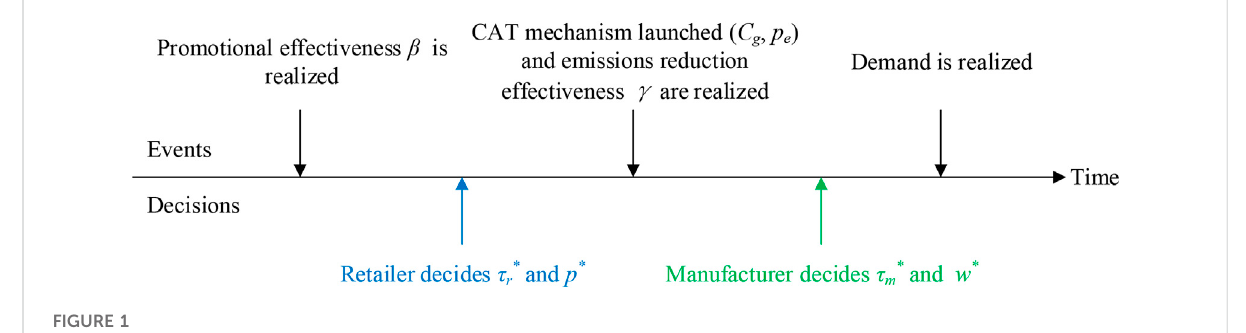
FIGURE 1 Two-echelon supply chain